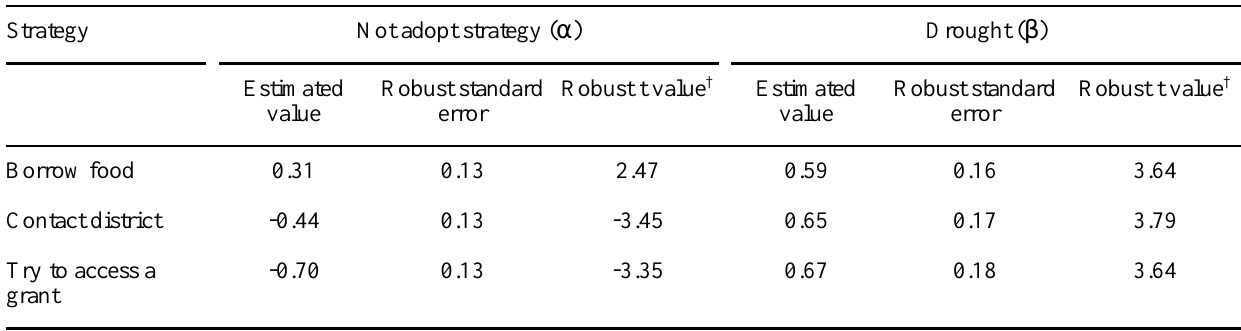
Table 5. Binary logit model for significant strategy choices under drought